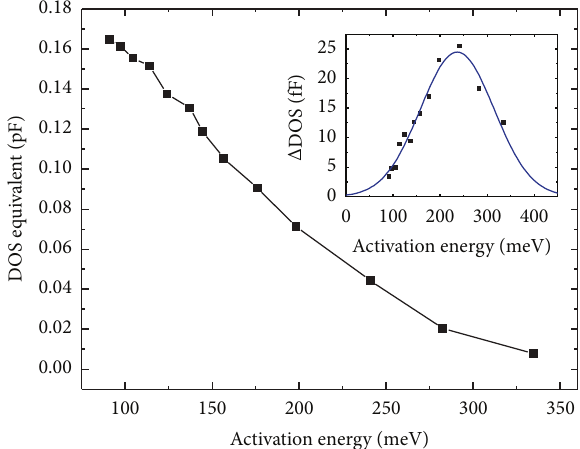
Figure 6: Peak heights as function of measurement voltage 𝑉 𝑚 . The insets schematically show the contribution of QDs with different individual localization energies. The shaded areas indicate the energy range that is probed during a single measurement step. The localization energy of each individual QD depends on the dot size and its composition which have not been indicated in the insets separately.